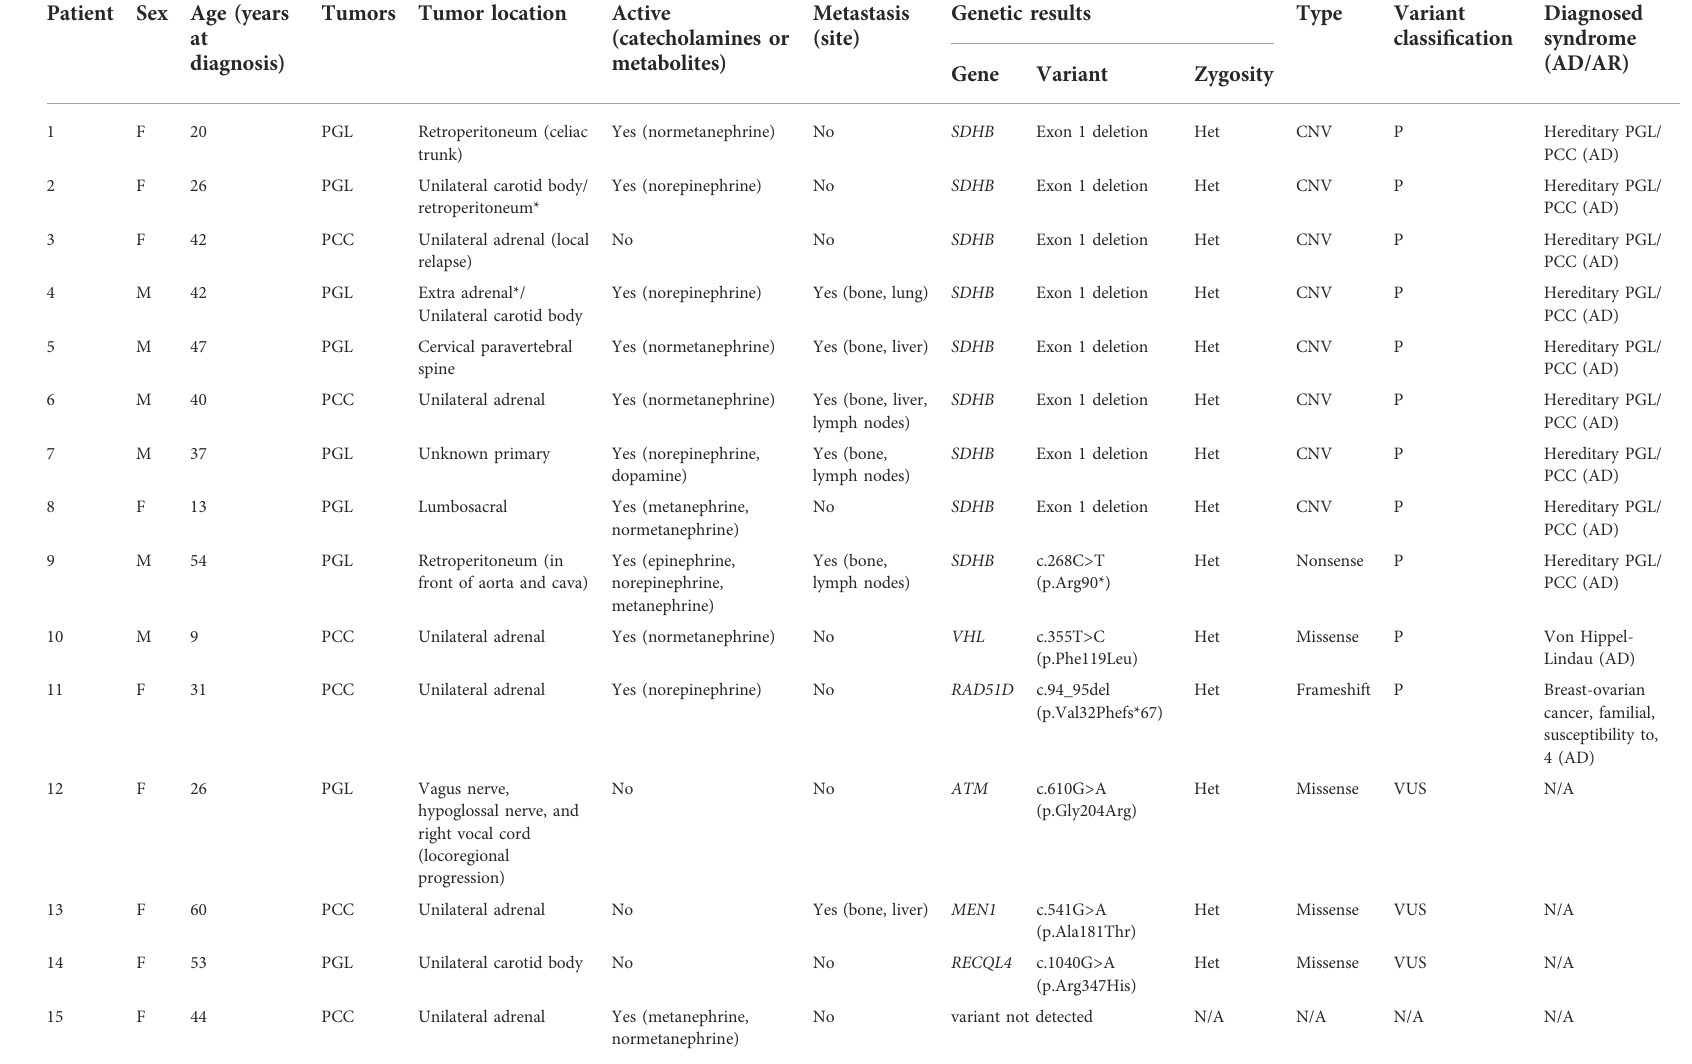
TABLE 2 Clinical characteristics and genetic test results of patients with pheochromocytoma/paraganglioma (n = 19). Patient Sex Age (years